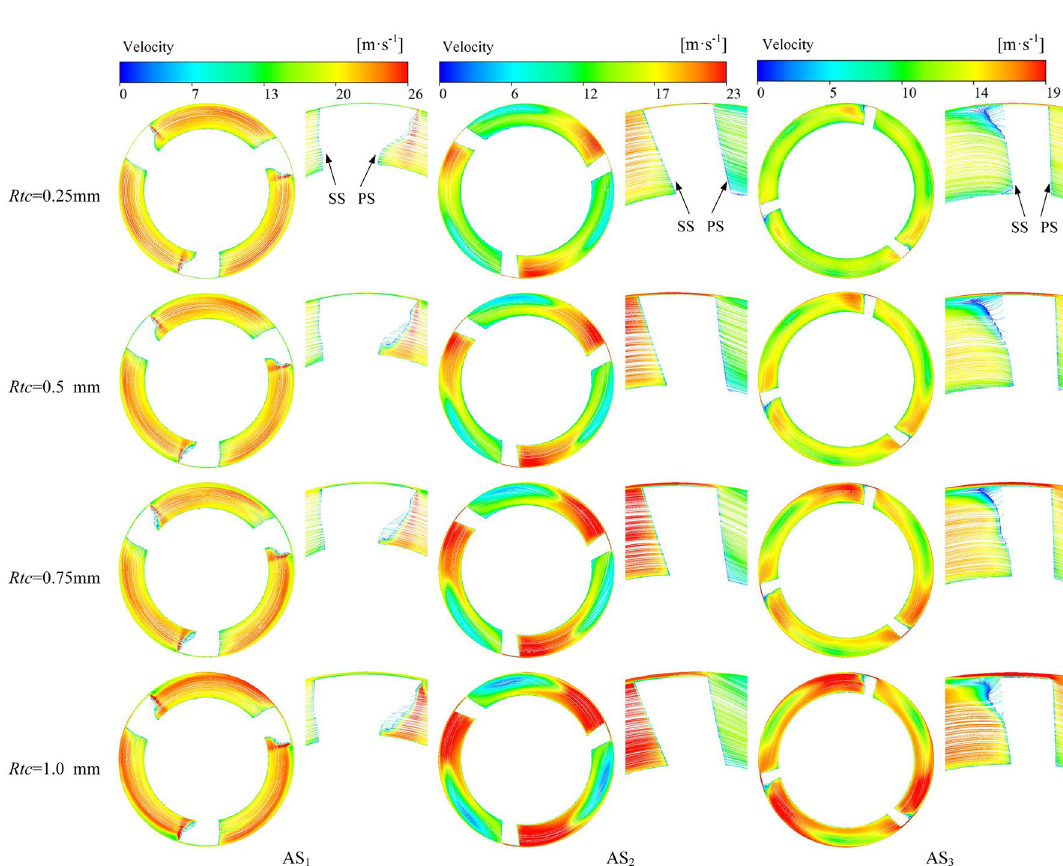
Figure 11. Velocity streamlines on axial